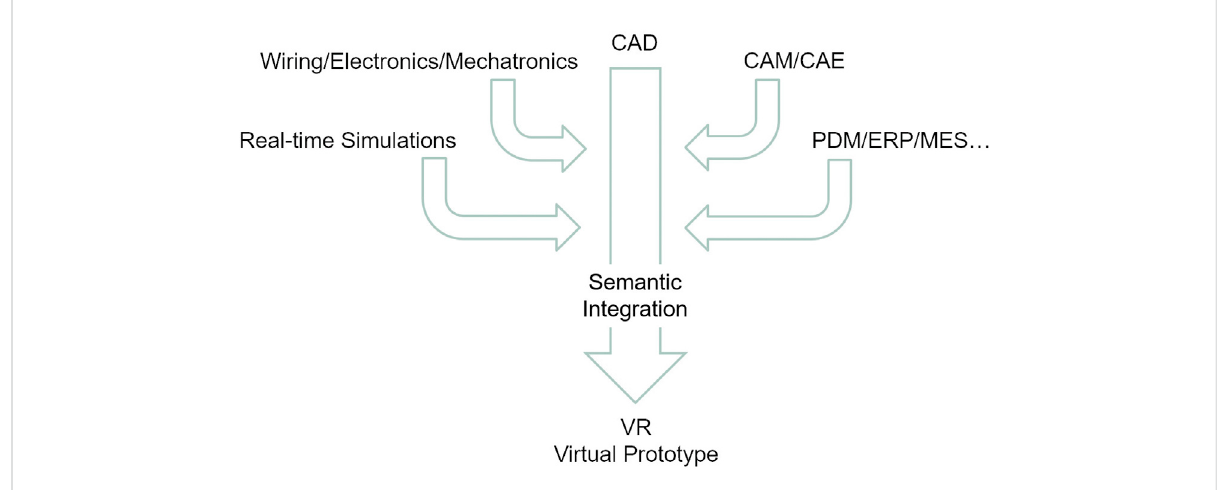
FIGURE 6 Integration of heterogeneous data sources towards the virtual